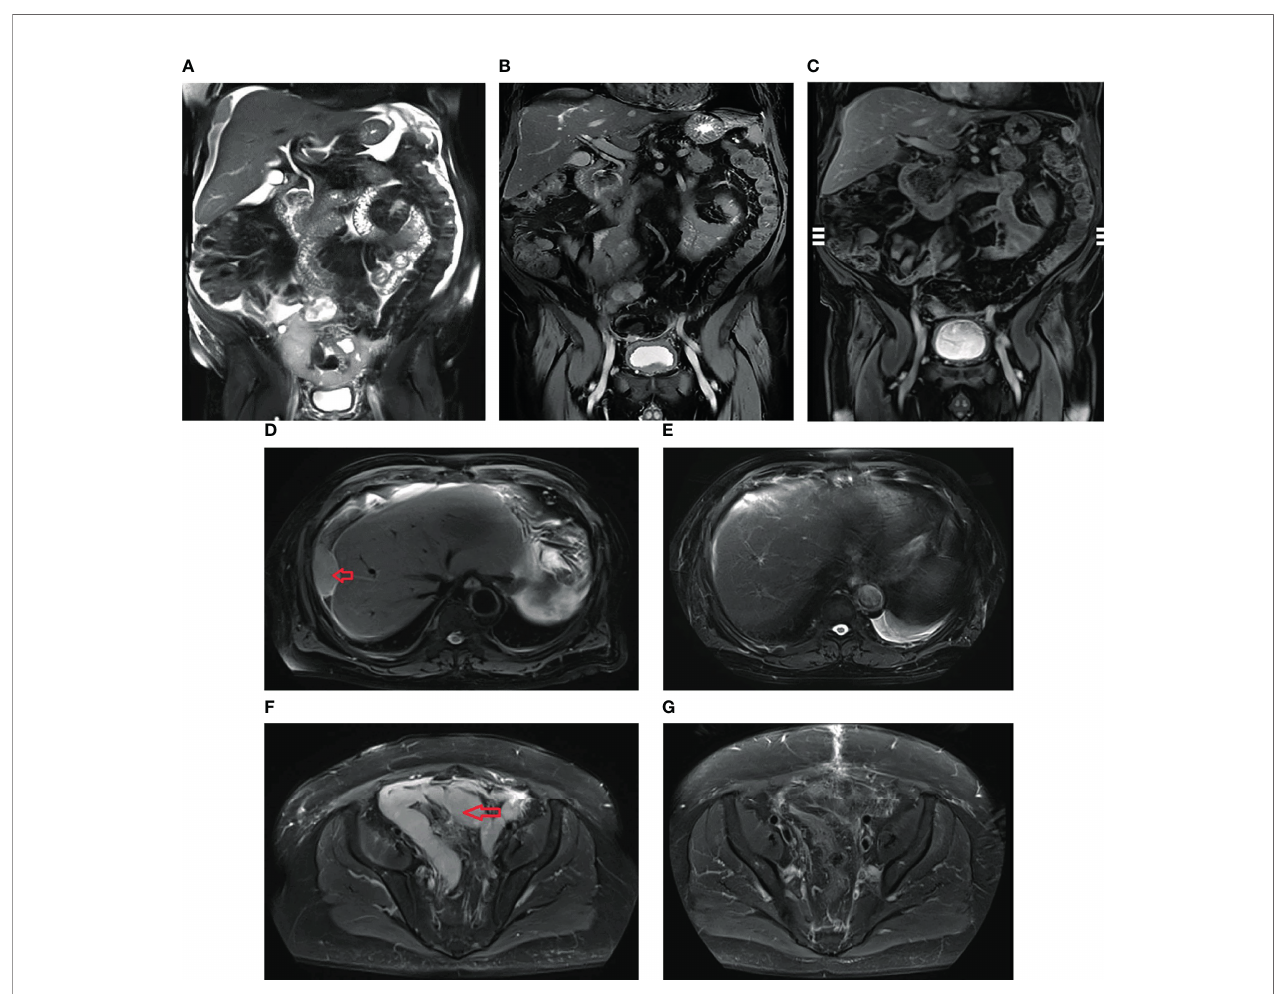
FIGURE 2 | T2 sequence of coronal MRI: (A) before initial treatment with systemic chemotherapy (SC): massive ascites and the tumors; (B) after four cycles of SC: ascites disappeared, and the tumors became smaller and fewer in number; (C) after SC + cytoreductive surgery (CRS) + adjuvant chemotherapy treatment: the intra- abdominal tumor had resolved 3/4. T2 sequence of axial MRI: (D) before initial SC, arrow: peritoneal tumor; (E) after SC + CRS + adjuvant chemotherapy treatment, the tumor mass showed a complete response; (F) before initial SC, arrow shows “ N ” -shaped giant tumors; (G) after SC + CRS + adjuvant chemotherapy treatment, the tumors became smaller and fewer in